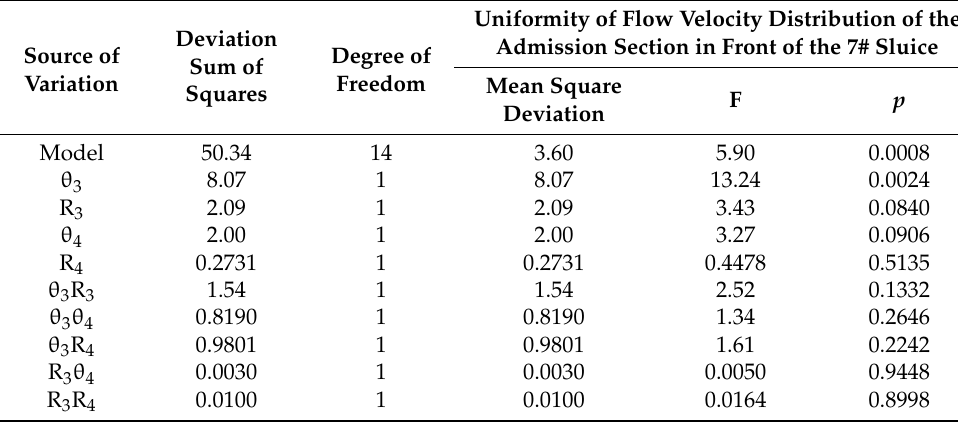
Table 6. Significance test of the regression equation (operational state of